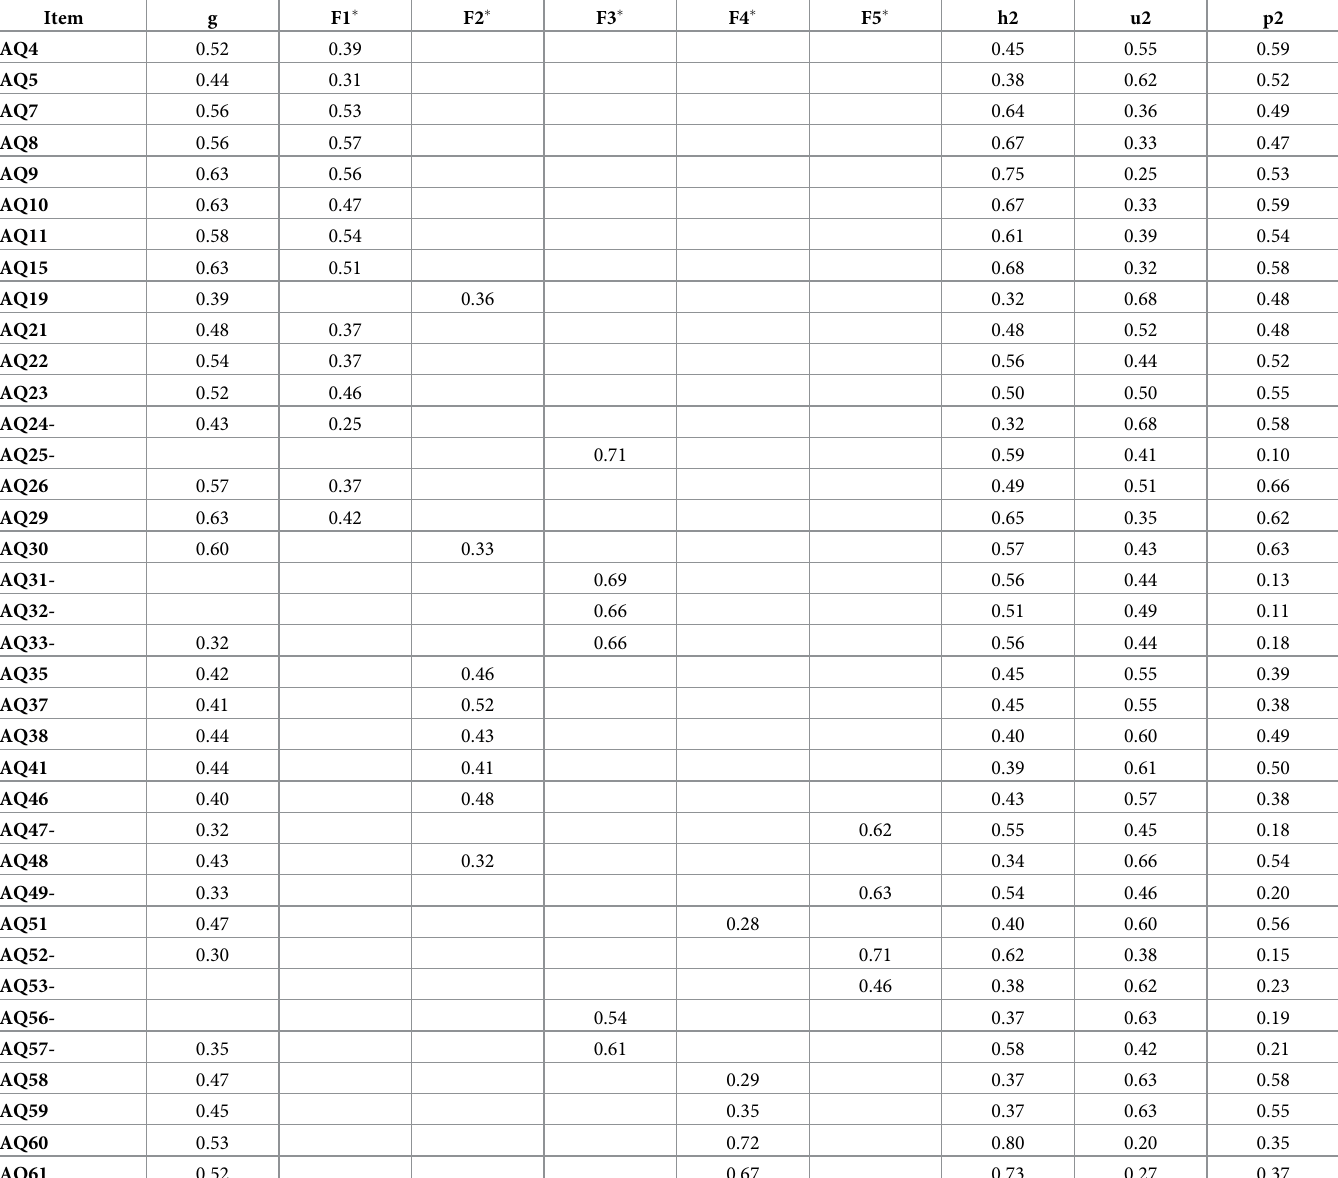
Table 2. Schmid-Leiman factor loadings (g—general factor, F1 � to F5 � group factors), communality (h2), uniqueness (u2) and proportion of communality accounted for by the general factor